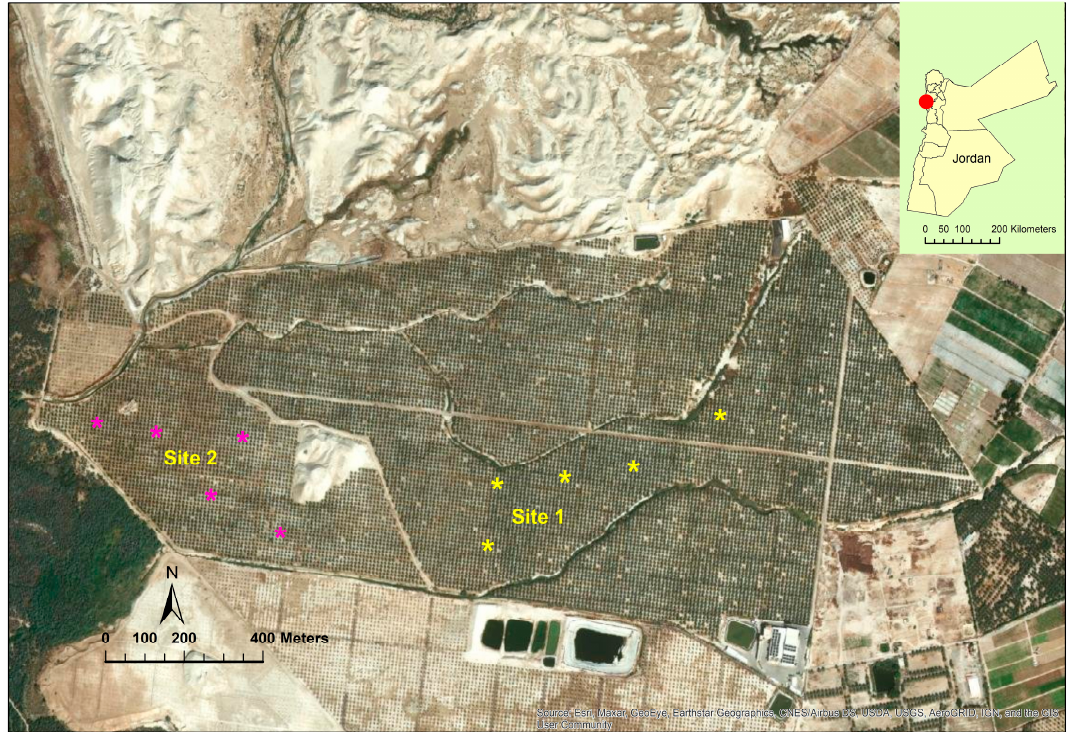
Table 1. Soil analysis of experimental sites at the Medjool Village, Jordan Valley, Jordan.